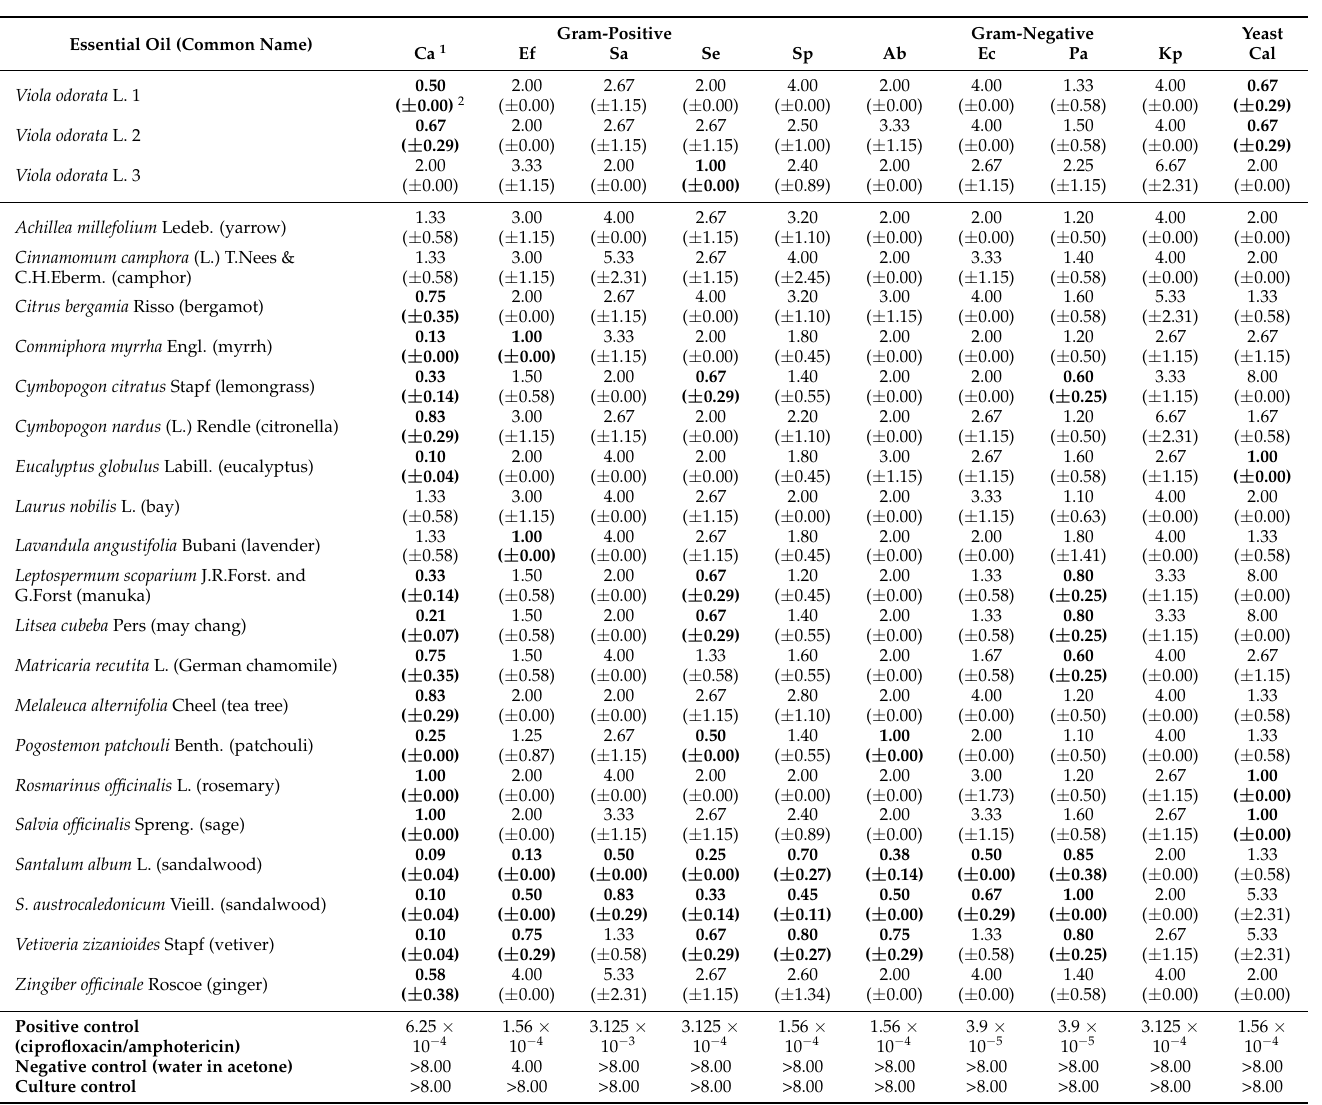
Table 3. Antimicrobial activity (mg/mL) of essential oils against the selected pathogen reference strains ( n =